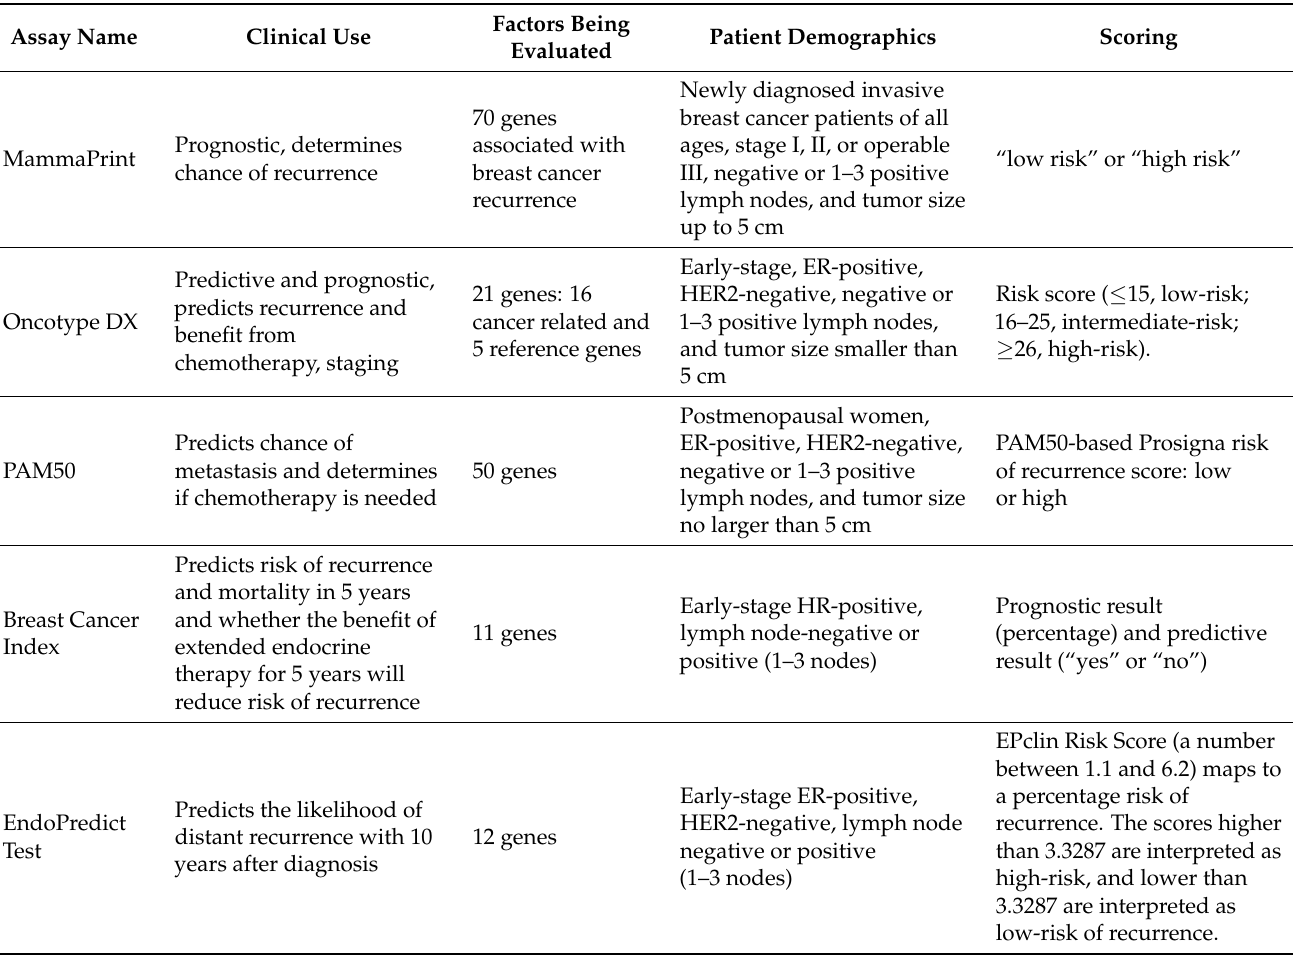
Table 4. Common gene expression-based assays in breast